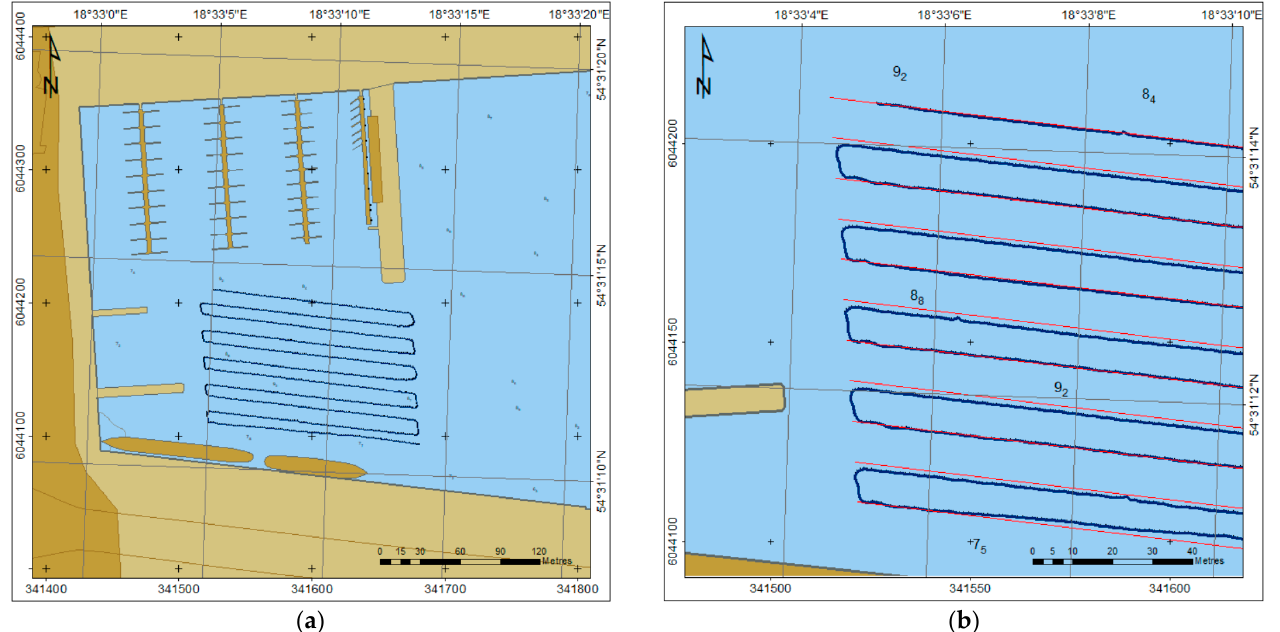
Figure 4. USV trajectory in open area ( a ), trajectory in the background of survey lines ( b